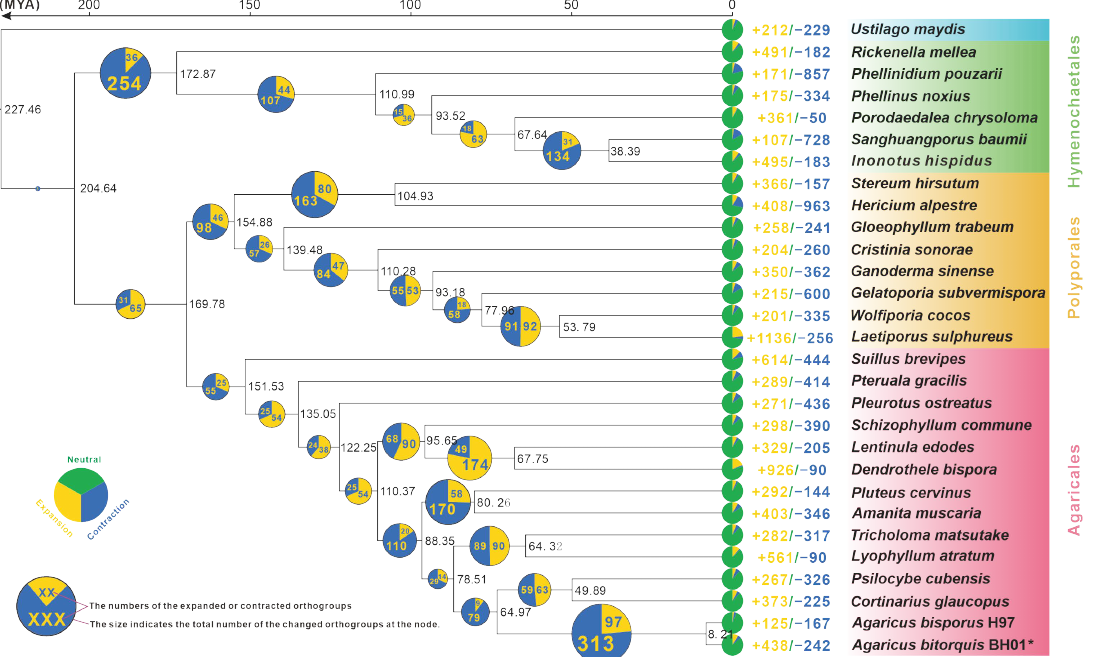
Figure 3. The evolutionary relationship and expanded and contracted gene families among Agaricus species and 27 representative Basidiomycetes. The maximum likelihood method credibility tree was inferred from 27 single-copy orthologous genes. All nodes received full bootstrap support. The diver- gence time is labeled as the mean crown age for each node, while the 95% highest posterior density is also given within the Agaricus clade. The black numbers at the branches indicate the corresponding divergence times in millions of years (MYA). The proportion of expansion and contraction in the genome of each species was displayed before its species